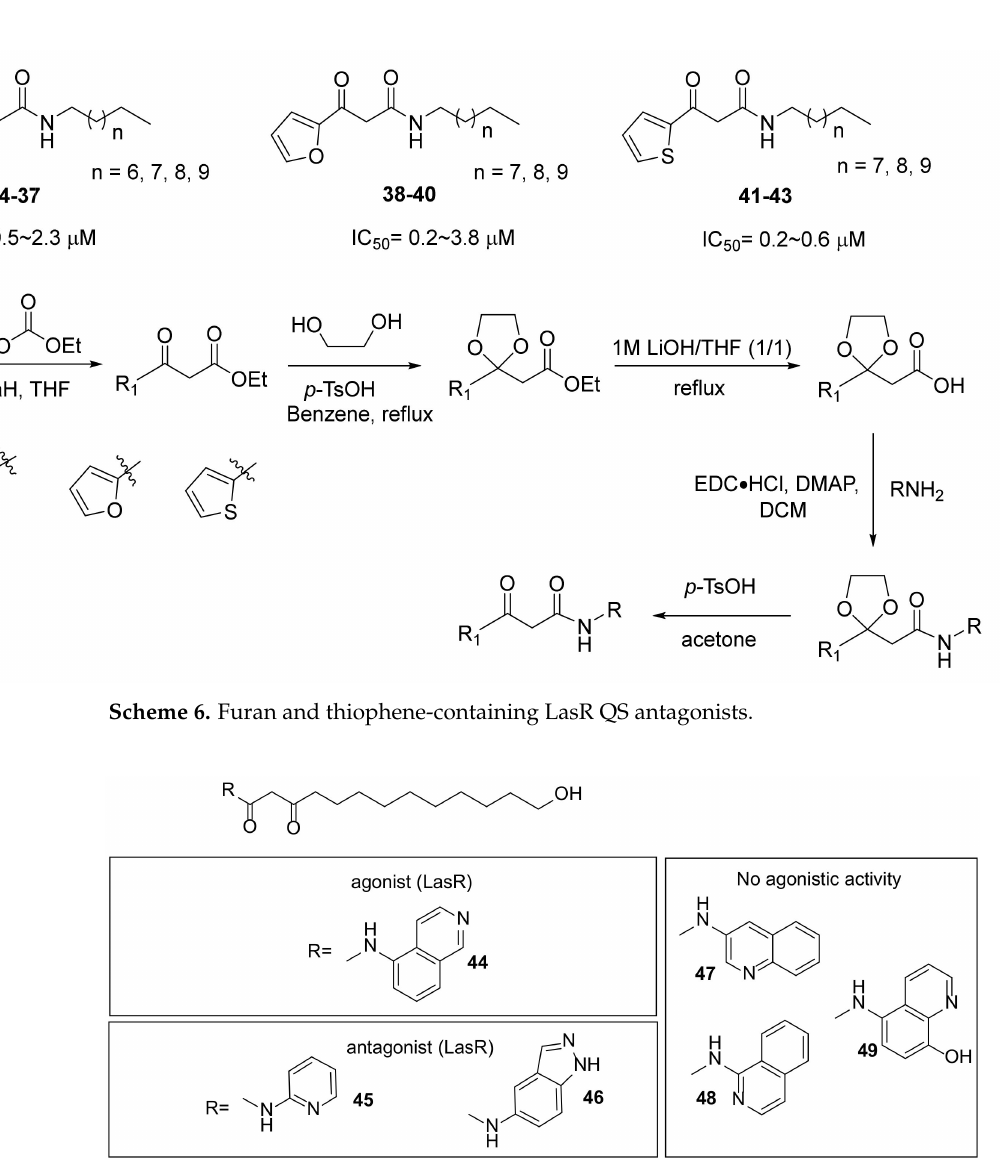
Figure 8. Examples of heteroaromatic QS modulator identified by Suga’s group. Other heterocyclic systems have been used for the design of AHL unrelated CviR- regulated QS modulators of such as thiazoles, thiazolines, benzimidazoles, pyridines represented in Scheme 7 [46]. The amino-thiazoles were prepared with thiourea and ethyl bromopyruvate and subsequently acylated using DCC as the coupling reagent. Thiazo- line derivatives were synthesized by reaction of 4-aminobenzonitrile with cysteamine hydrochloride and subsequent acylation with carboxylic acid under microwave activation. The benzimidazoles derivatives were prepared by reaction of disulfide with 4-chloro-1,2- phenylenediamine to afford 5-chloro-benzimidazole-2-thione, which were further alkylated with various bromoacetamides or with bromononane. Finally, the pyridine derivatives were prepared from 5-chloro-2-aminopyridine through direct acylation with carboxylic acid under microwave